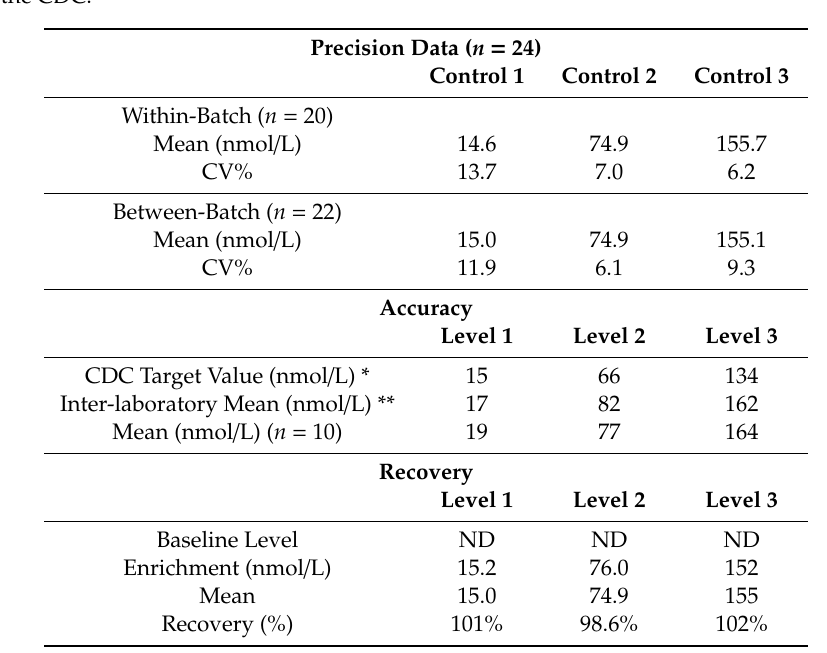
Table 1. Precision, Accuracy, bias and recovery data for 17OHP in bloodspots by LC-MSMS. * Target value assigned by the CDC. ** LCMSMS method mean ( n = 79) from laboratories submitting analytical data to the CDC.